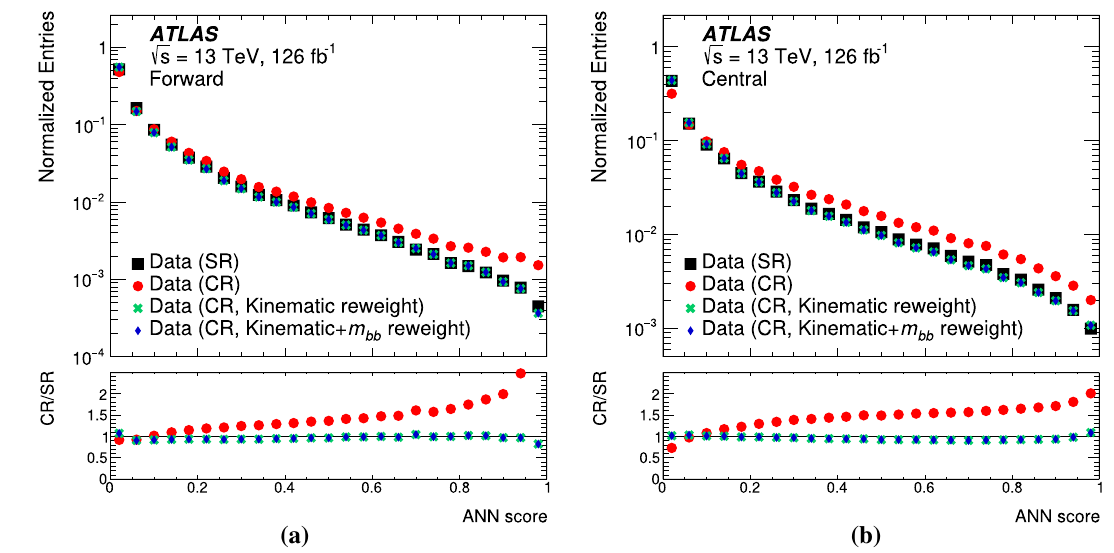
Fig. 3 Comparison of the ANN score distributions for the signal and control regions: a shows the Forward channel, b shows the Central channel. The SR selected data are shown in black squares, the CR selected data are shown in red circles prior to reweighting, in green